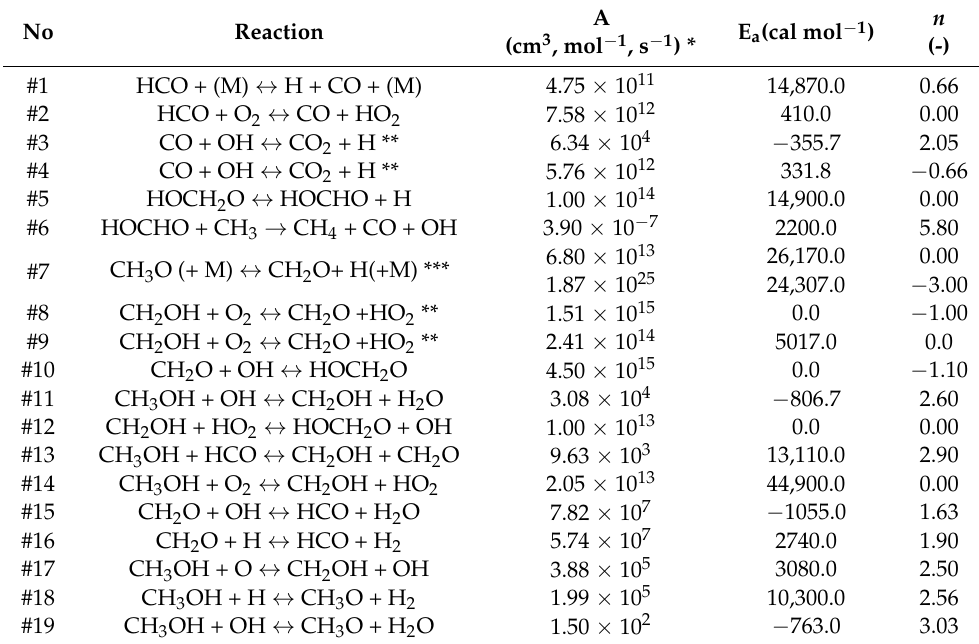
Table 2. Reduced mechanism for methanol as obtained in this work and implemented in CFD. No